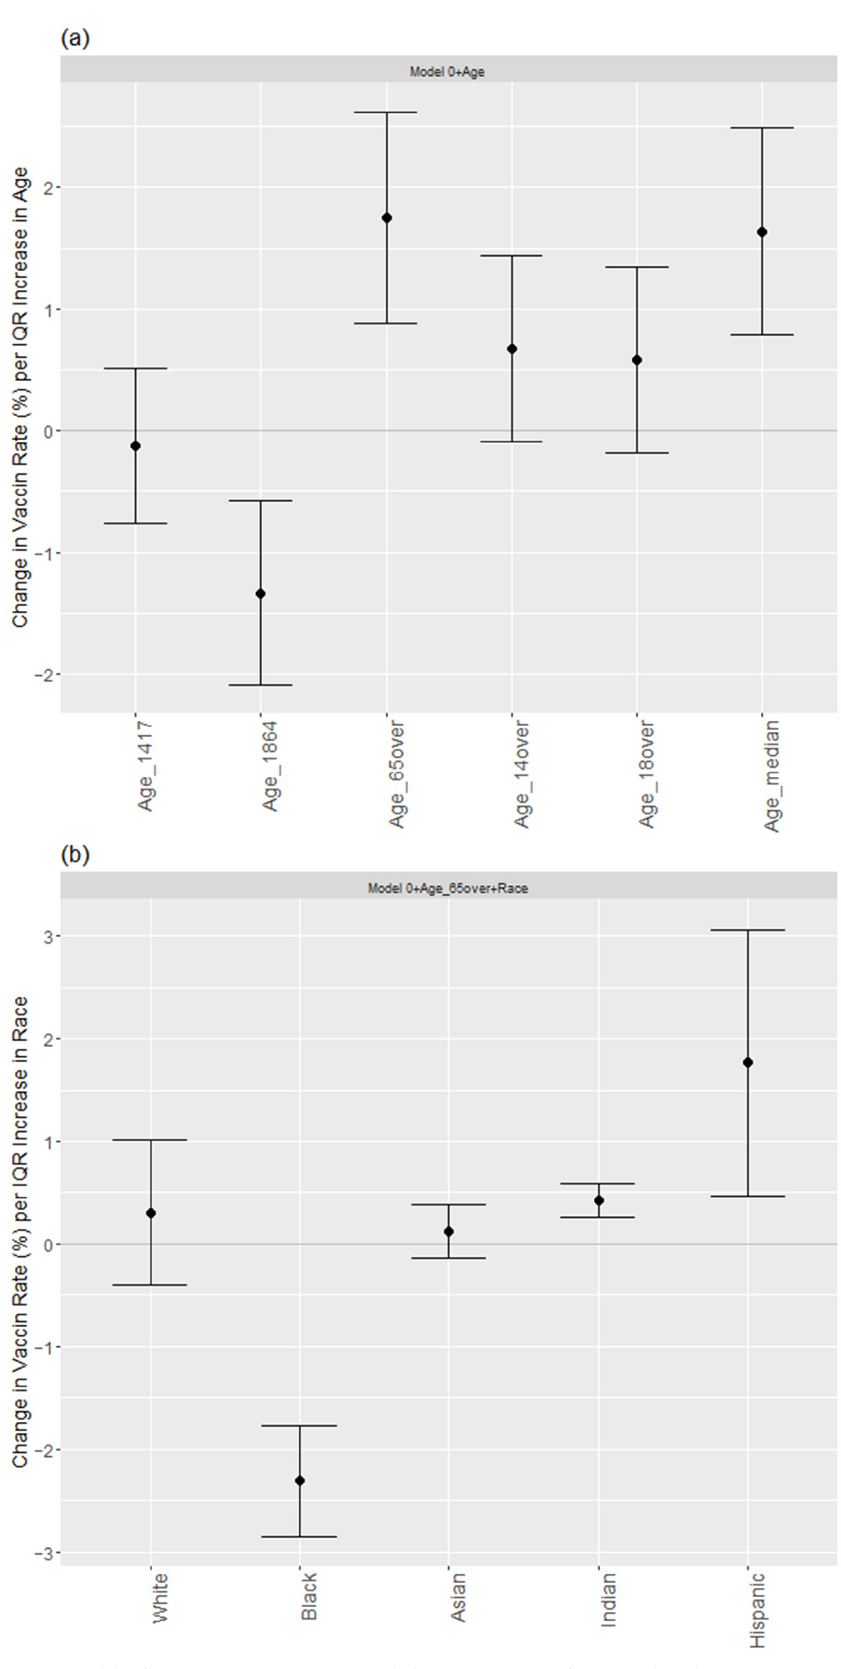
Figure 4. ( a ) Change in vaccination rate (%) per interquartile range (IQR) increase in each age vari- able; ( b ) Change in vaccination rate (%) per interquartile range (IQR) increase in each race/ethnicity variable.